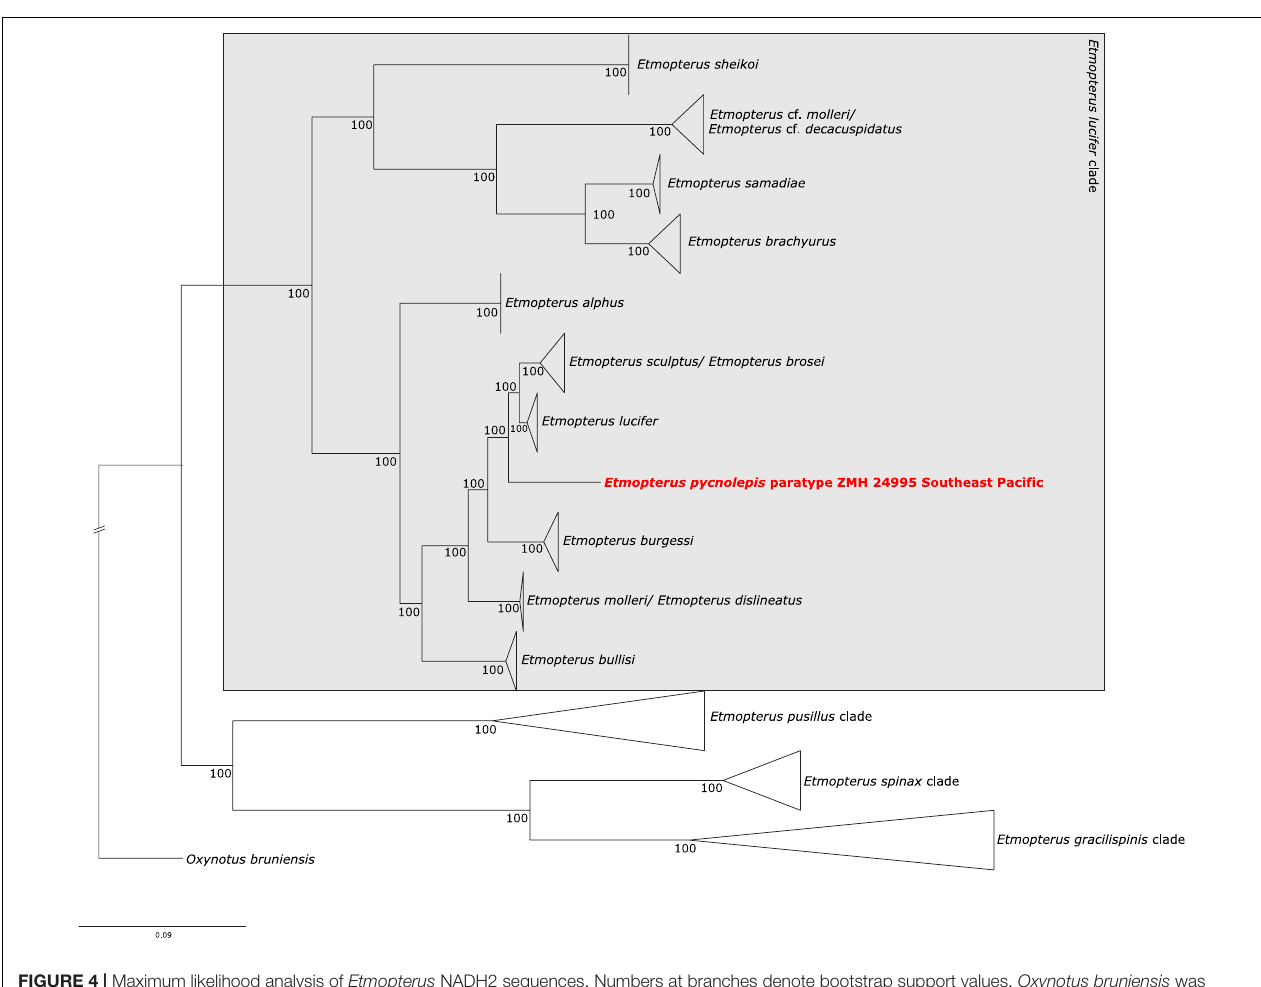
Figure 1B . The modal fragment length is around 50 base pairs. Mapping those reads back to the reconstructed NADH2 consensus sequence, showed that 277 reads mapped with an average coverage of 13 reads, excluding duplicate sequences ( Supplementary Figure 2B ). The maximum likelihood NADH2 phylogeny shows well-supported clades within the E. lucifer group. Several clades do not correspond to species: E . brosei clusters with E. sculptus, E. cf. molleri clusters with E. cf. decacuspidatus and forms a distinct clade not including E. molleri. Etmopterus molleri and E. dislineatus do not form two distinct clades. The E. pycnolepis paratype specimen is sister to a clade containing the southern hemisphere samples of E. lucifer and E. sculptus ( Figure 4 ). The species delimitation analysis shows that the interspecific K2P distance of the NADH2 gene between sequences of two valid species in the E. lucifer clade, excluding clades not corresponding to species, is on average 4% ( Supplementary Table 3B ). Comparing the K2P distance of E. pycnolepis to its closest sister taxon, E. lucifer , the K2P distance is 3.4%. Our data therefore supports the species status of E. pycnolepis